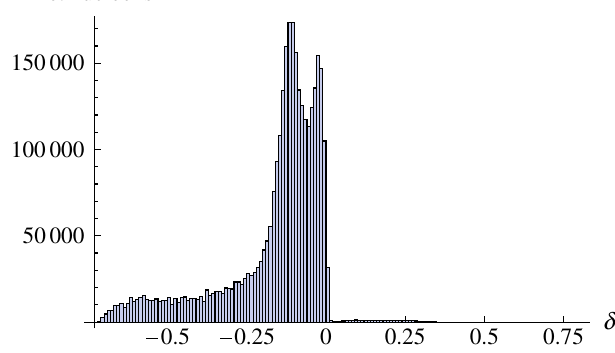
FIG. 17. (Color) Measured and simulated 208 Pb 82 þ loss maps with parallel jaws for a 5 : 9 GeV = nucleon beam injected on the collimator (green bars) and circulating 106 : 4 GeV = nucleon (blue